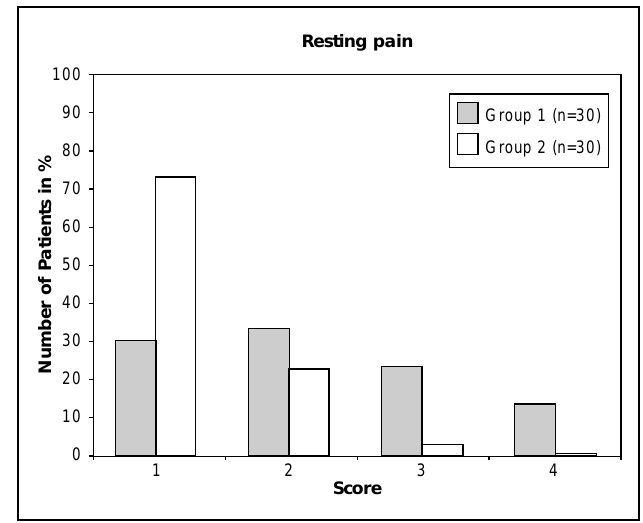
Figure 5: Distribution differences in movement pain at the end of six weeks of treatment in the therapy groups.